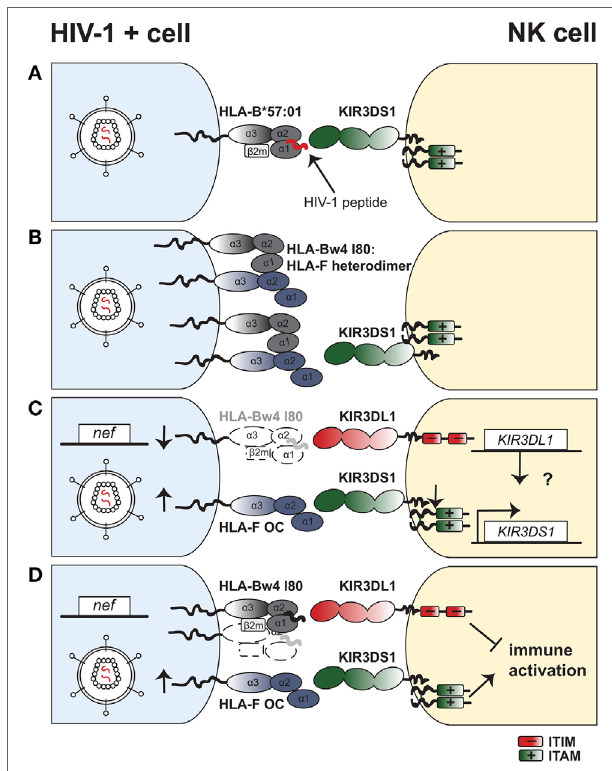
FigURe 1 | Four models with potential mechanisms to explain the underlying protective effect of the combined KIR3DS1 –HLA-Bw4 genotype in HIV-1 infection. (A) Viral peptides allow for KIR3DS1 binding to HLA-B*57:01 and trigger natural killer (NK)-cell activation. Presentation of viral peptides (in red) on HLA-B*57:01 upon HIV-1 infection of target cells (blue) enables binding of KIR3DS1 on NK cells (yellow). The short cytoplasmic tail of KIR3DS1 associates to the adaptor molecule DAP12, which bears two ITAMs. (B) HLA-Bw4 enhances human leukocyte antigen F (HLA-F) expression at the cell surface of HIV-1–infected cells. Open conformers of HLA-F exist as heterodimers with open conformers of HLA-Bw4 on the cell surface of HIV-1–infected cells. This enhances binding and triggering via KIR3DS1 on NK cells. (C) KIR3DS1:HLA-F and KIR3DL1:HLA-Bw4 interactions have independent but synergistic protective effects in HIV-1 infection. HIV-1 infection of target cells leads to downregulation of HLA-Bw4 from the cell surface via action of the accessory protein Nef. Loss of HLA-Bw4 on the infected cells leads to loss of inhibition via KIR3DL1. Simultaneously, cell stress induced by HIV-1 infection leads to upregulation of open conformers of HLA-F, which bind to KIR3DS1 and trigger NK-cell activation. A potential epistatic regulation of KIR3DS1 gene expression via the KIR3DL1 gene is depicted. (D) KIR3DL1:HLA-Bw4 I80 interactions limit KIR3DS1:HLA-F- mediated immune activation. HIV-1 infection directly (and indirectly) causes cellular stress, which in turn upregulates surface expression of HLA-F open conformers on CD4 + T cells and other cell types. OCs of HLA-F bind to KIR3DS1 and trigger NK-cell activation. On the other hand, KIR3DL1 binds to HLA-Bw4 molecules, which are present on HIV-1–infected cells, although at low levels due to HIV-1 Nef-mediated downregulation. Inhibitory signaling via KIR3DL1 limits NK-cell activation and inflammatory cytokine production, thus limiting activation via